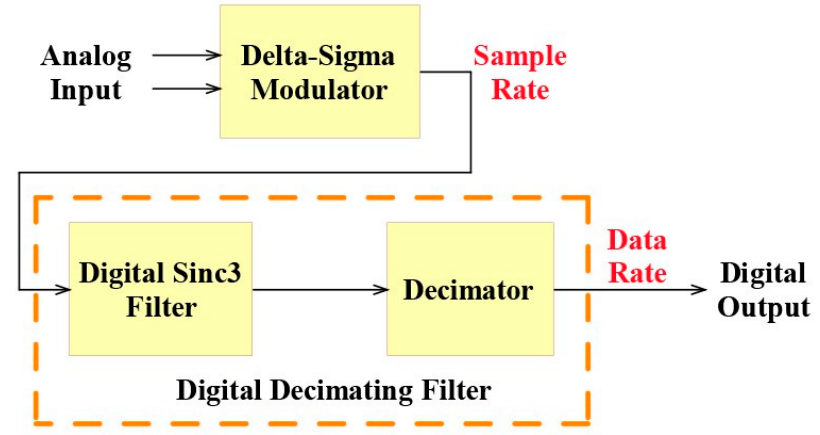
Figure 1. Internal block diagram of the ADC showing the core functions.